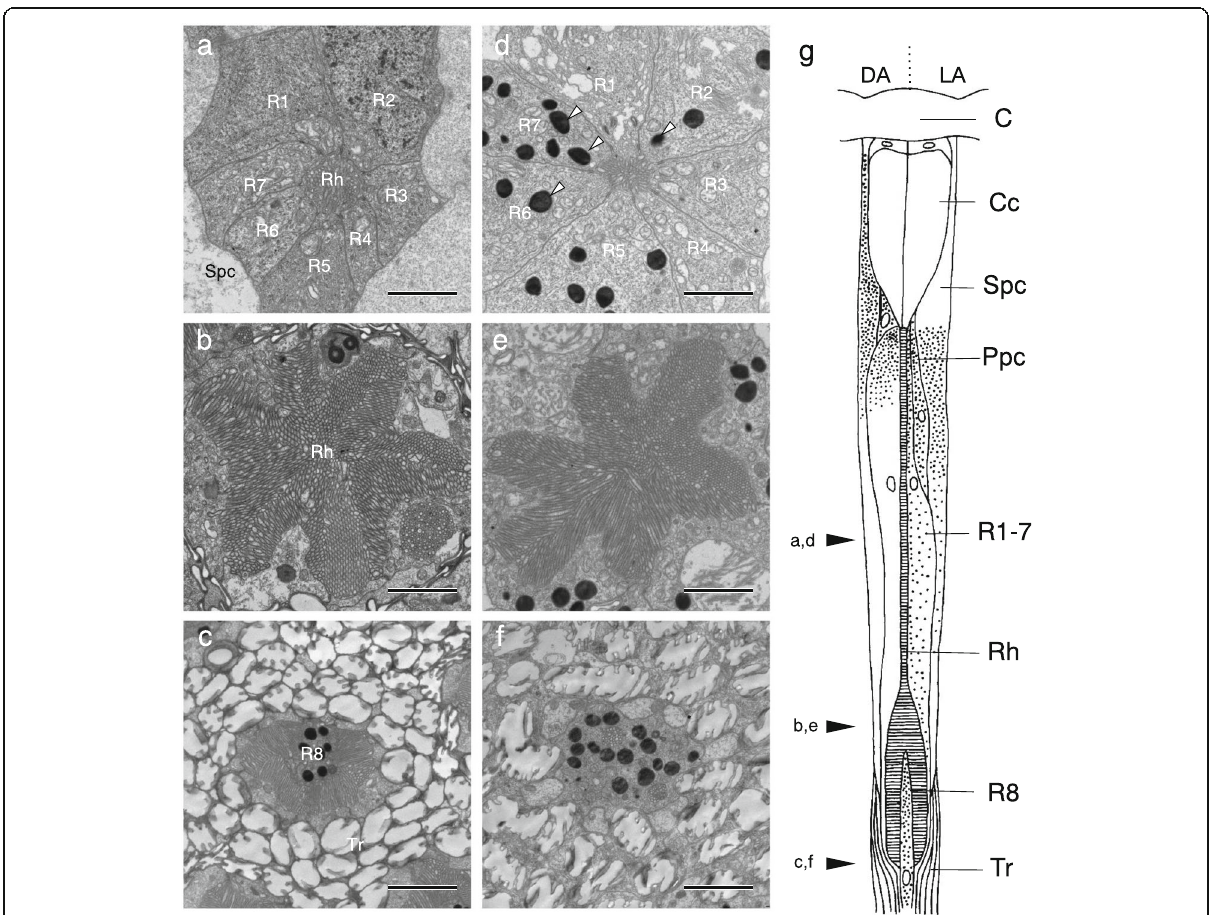
Fig. 1 Ommatidial structure of male Adoxophyes orana . Transverse sections of the rhabdom (Rh) region in dark-adapted ( a – c ) and light-adapted ( d – f ) eyes. The depths at which these sections were cut are indicated in the diagram ( g ) by three black arrowheads on the left. a Distal rhabdom (Rh) of a dark-adapted ommatidium. Seven photoreceptors (R1 – 7) are evident. Cell bodies of photoreceptors and secondary pigment cells (Spc) are free of pigment granules. b Proximal rhabdom. c Basal rhabdom. Pigmented cell is the eighth and basal photoreceptor, R8. The ommatidia are surrounded by numerous tracheoles (Tr). d Distal rhabdom of a light-adapted ommatidium. Pigment granules (white arrowheads) exist in the region close to the rhabdom. e Proximal rhabdom. f Basal rhabdom. g Diagram of an ommatidium in dark- (left) and light- (right) adapted states. C, cornea; Cc, crystalline cone; Ppc, primary pigment cell. Scale bars = 2 μ